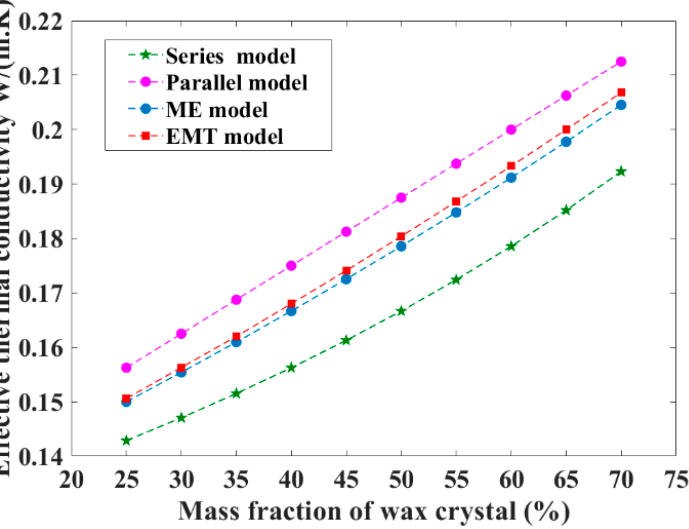
Figure 4. The calculated value of effective thermal conductivity. As can be seen from the Figure 4, the effective thermal conductivity increases with the mass fraction of wax crystal, and the calculation result of the Parallel method is the largest while the Series method is the smallest, and the calculation result of the ME and the EMT method is moderate. When the mass fraction of wax crystal is in the range of 30% to 65%, the effective thermal conductivity of the wax layer is in the range of 0.155–0.195 W/(m · K). In this work, combined with the calculation method of effective thermal conductivity above, we compared the simulation results with the experimental measurements. At the pipeline site, five temperature detecting sensors are set at the starting point (A to E). At the end of the pipeline, a similar location of sensors was adopted (F to J). The installation positions of the sensor are shown in Figure 5. The distance from point A to the ground surface is 1.0 m.